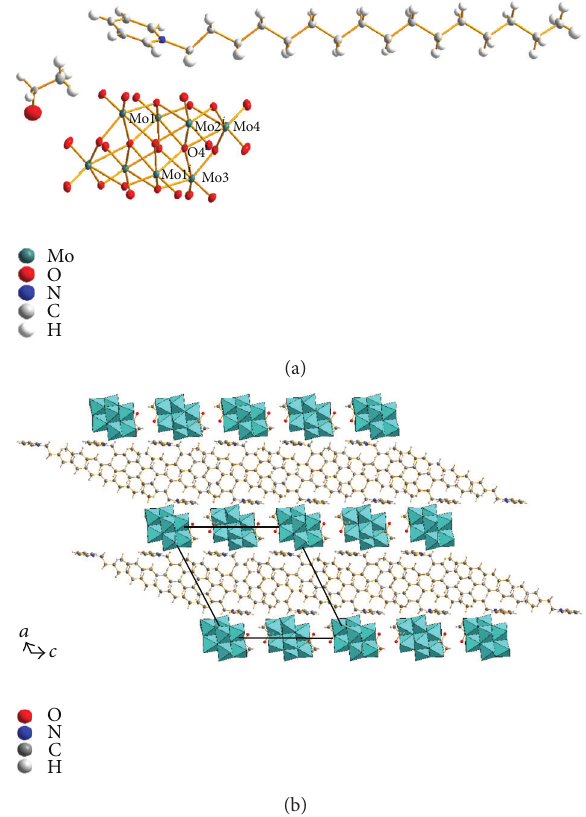
Figure 3: Crystal structure of C 16 py-H 2 Mo 8 . (a) Asymmetric unit together with atoms generated by the symmetry operation ( −𝑥,−𝑦,−𝑧 ) to complete half 𝛽 -H 2 Mo 8 anion (symmetry code: (i) −𝑥,−𝑦,−𝑧 ). Displacement ellipsoids are drawn at the 30% probability level. (b) Packing diagram along b -axis ( 𝛽 -H 2 Mo 8 in polyhedral